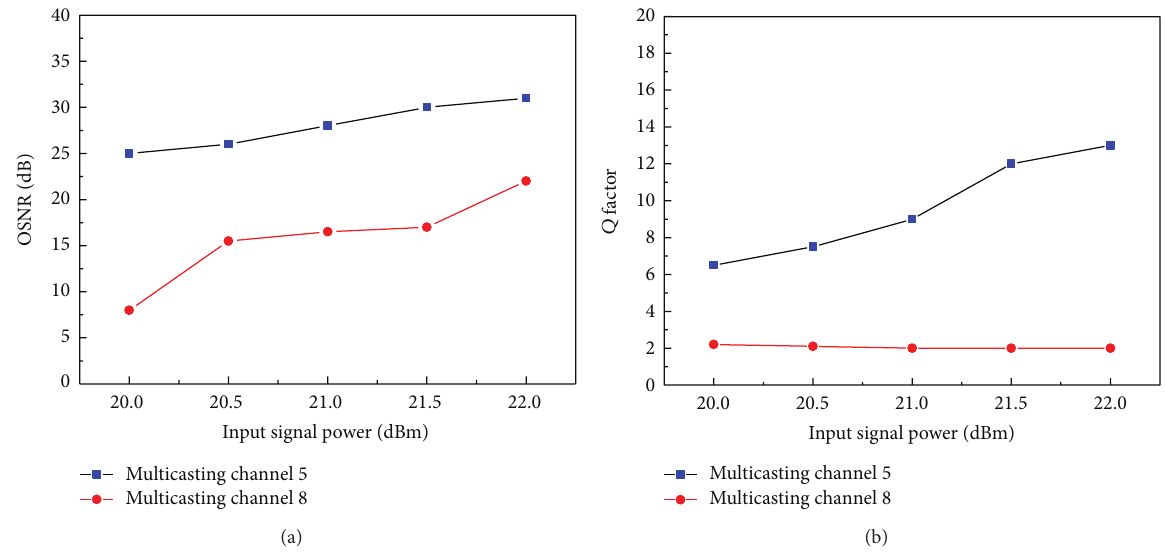
Figure 10: Dynamics characteristics of DF-HNL-PCF based wavelength multicasting scheme: (a) the OSNR and (b) 𝑄 factor versus input signal